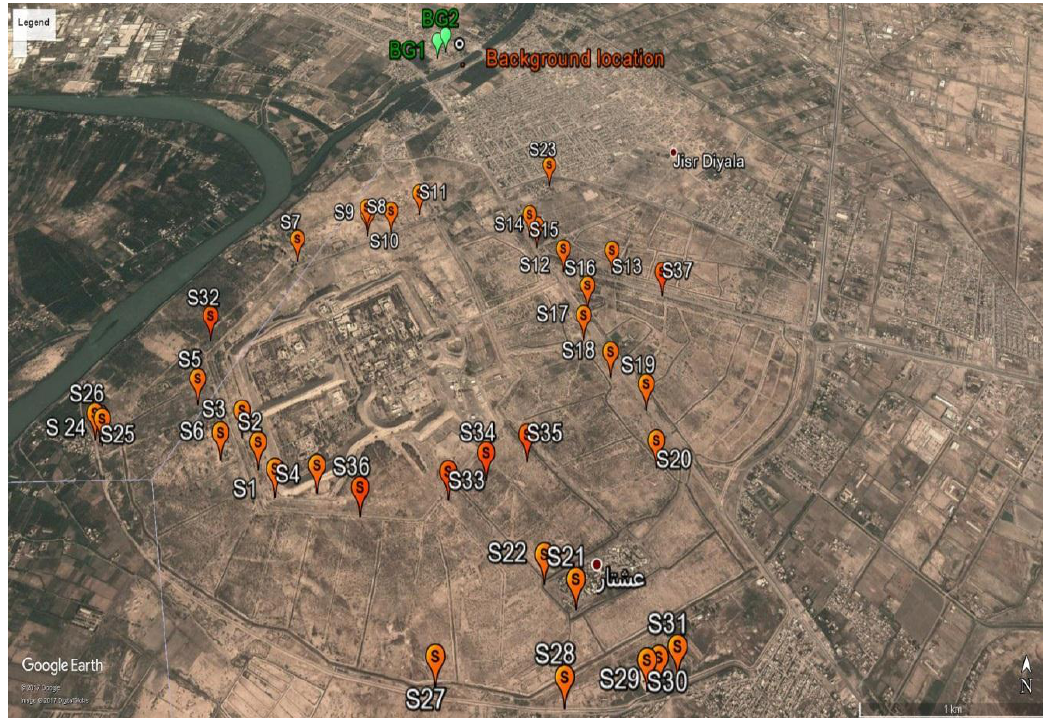
Fig.1: The location of samples in the area around the berms of Al-Tuwaitha site and background samples.